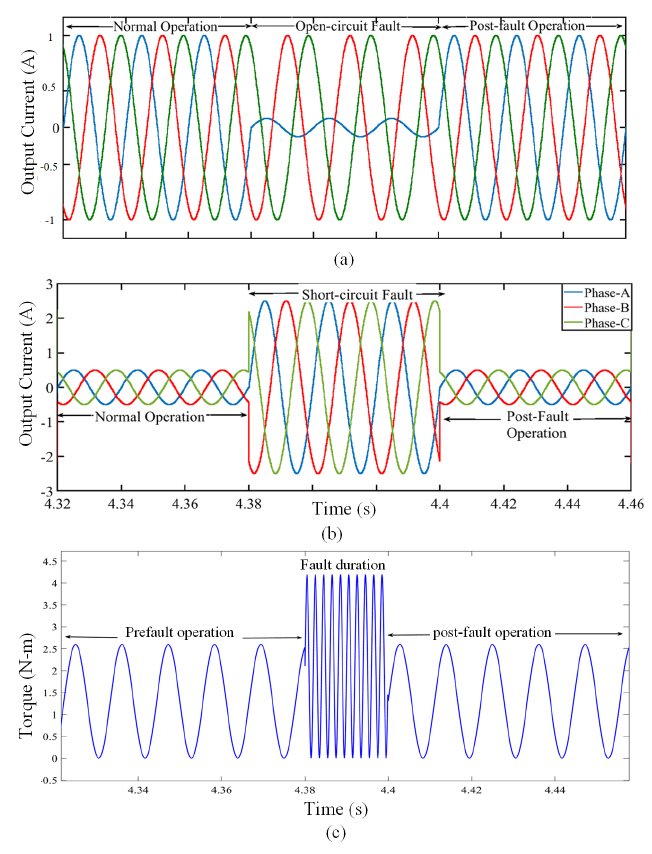
Figure 9. Simulation results under fault-tolerant control (FTC) operation: ( a ) Output current under open-circuit fault, ( b ) output current under short-circuit fault, and ( c ) torque